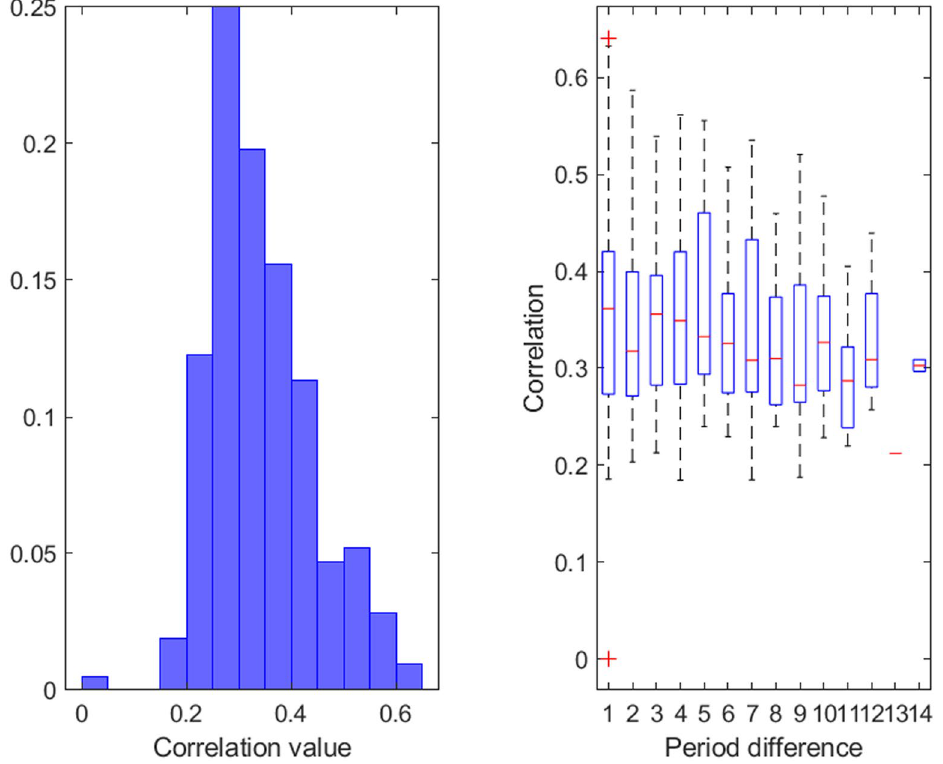
Figure 3. Distribution of the significant correlations between different periods (left) and boxplot of the significant correlations between different periods according to the different in time between periods (e.g. 2 represent a difference of 2